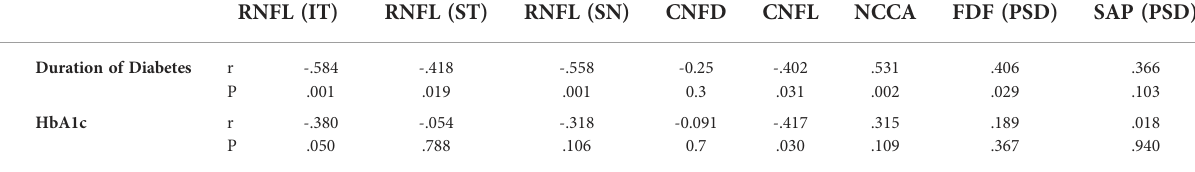
TABLE 3 Correlation between duration of diabetes & HbA1c with corneal and retinal markers of neural